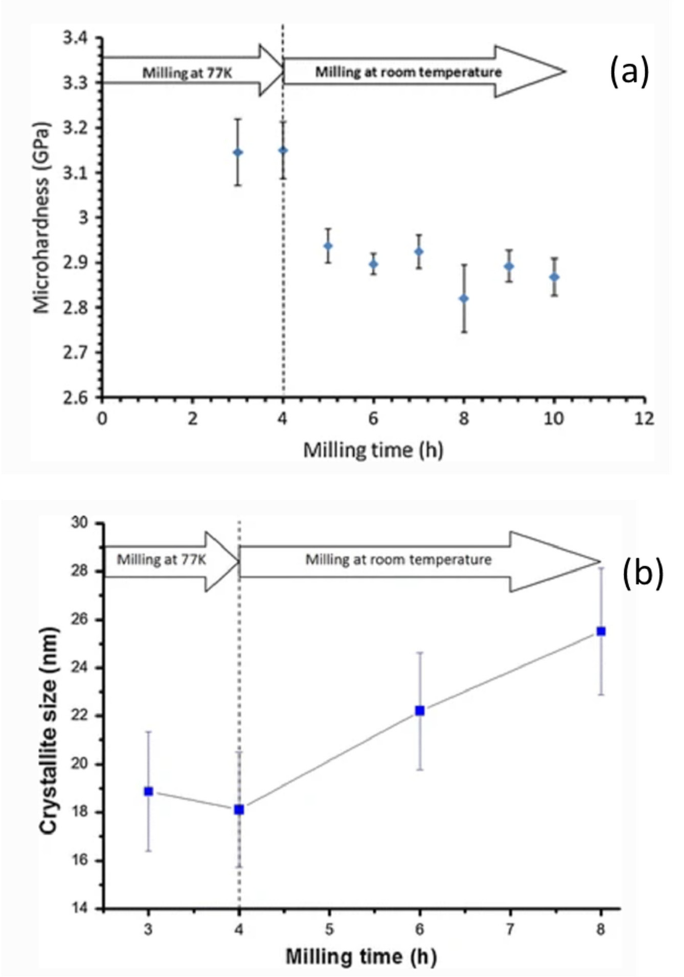
Figure 5. ( a ) Microhardness vs. milling time and ( b ) crystallite size vs. milling time for Cu-10wt% Zn alloy cryomilled for 4 h at 77 K followed by 6 h room temperature milling. “Reprinted/adapted